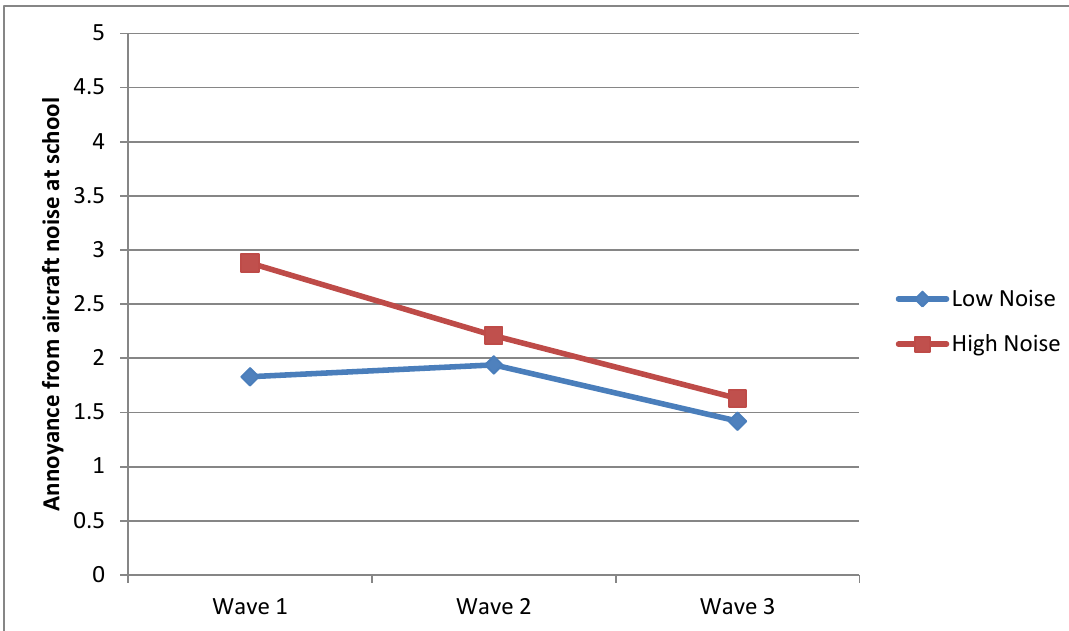
Figure 5. Annoyance reactions from aircraft noise at school.